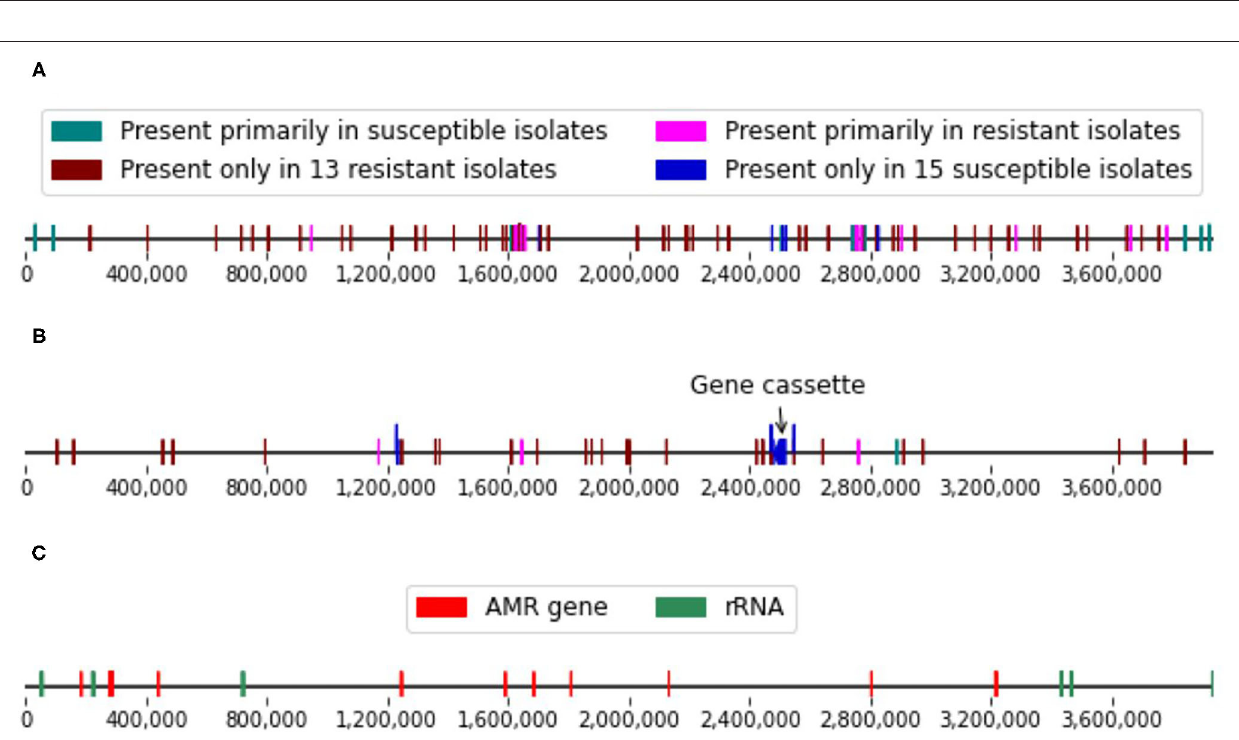
FIGURE 3 | (A) Single nucleotide polymorphism (SNP) and (B) conserved genomic regions ( ≥ 500 nt in length) strongly associated with the imipenem-resistance phenotypes and located on the reference genome. (C) Locations of the known resistance genes and ribosomal RNA genes in the reference